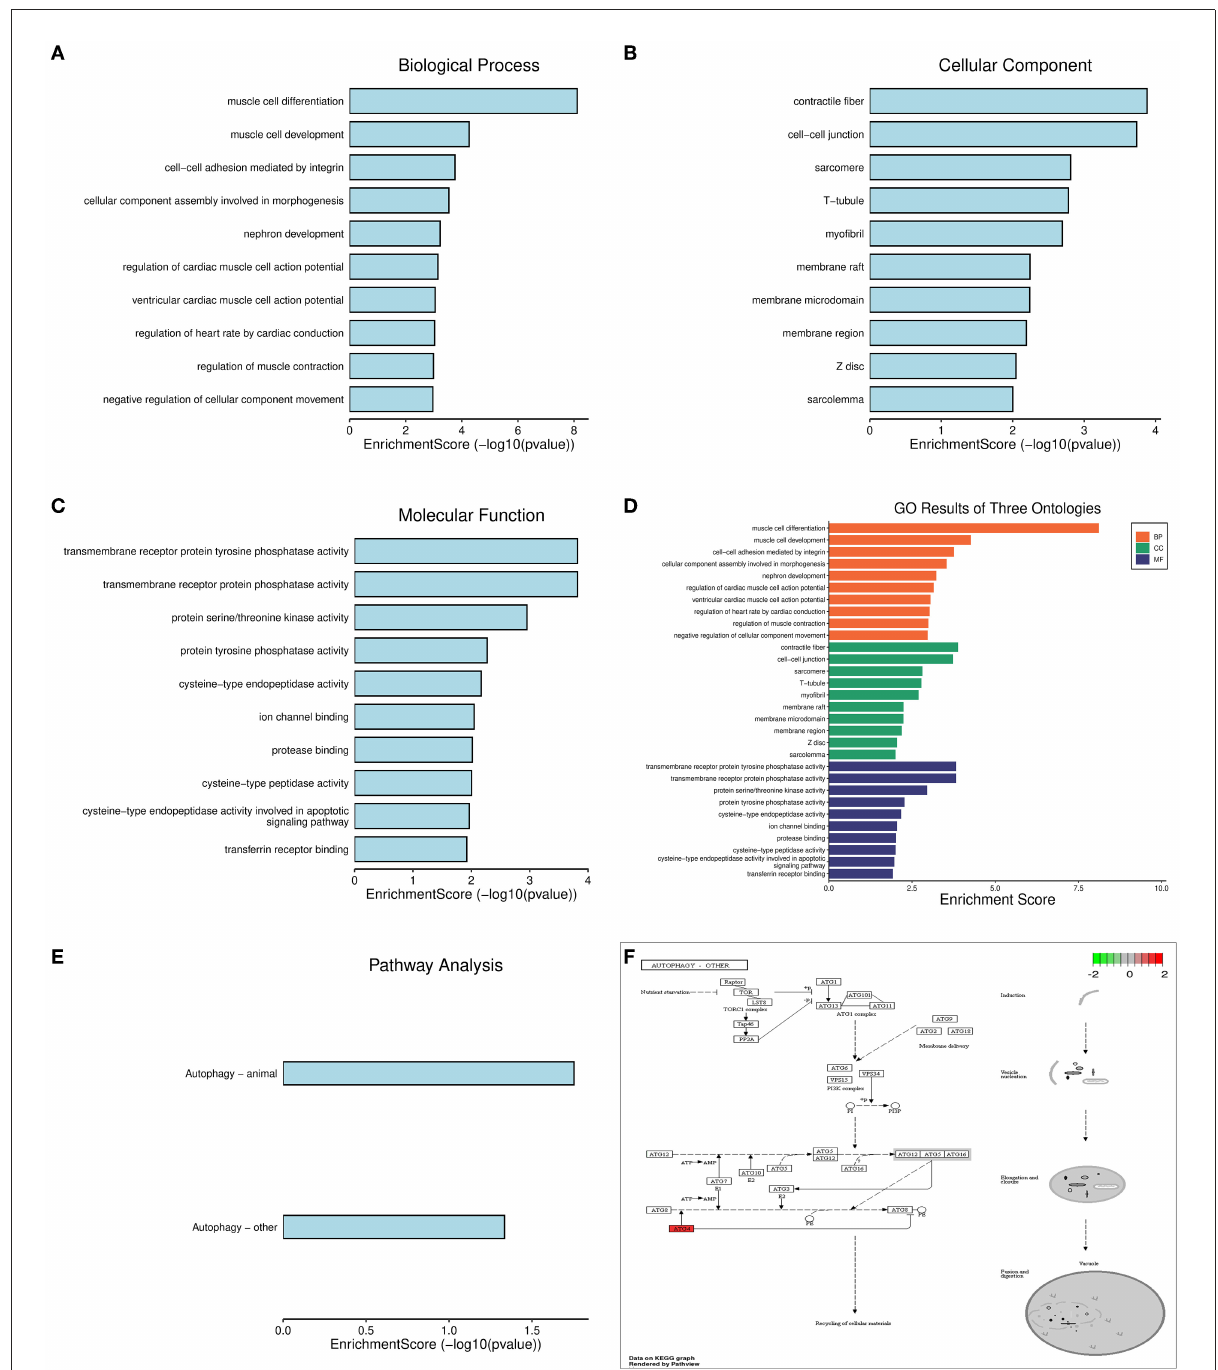
FIGURE5 GO and KEGG enrichment analysis. (A) Histogram of BP functional analysis. (B) Histogram of CC functional analysis. (C) Histogram of MF functional analysis. (D) Histogram of GO enrichment analysis. (E) Histogram of KEGG enrichment analysis. (F) Autophagy signaling pathway.